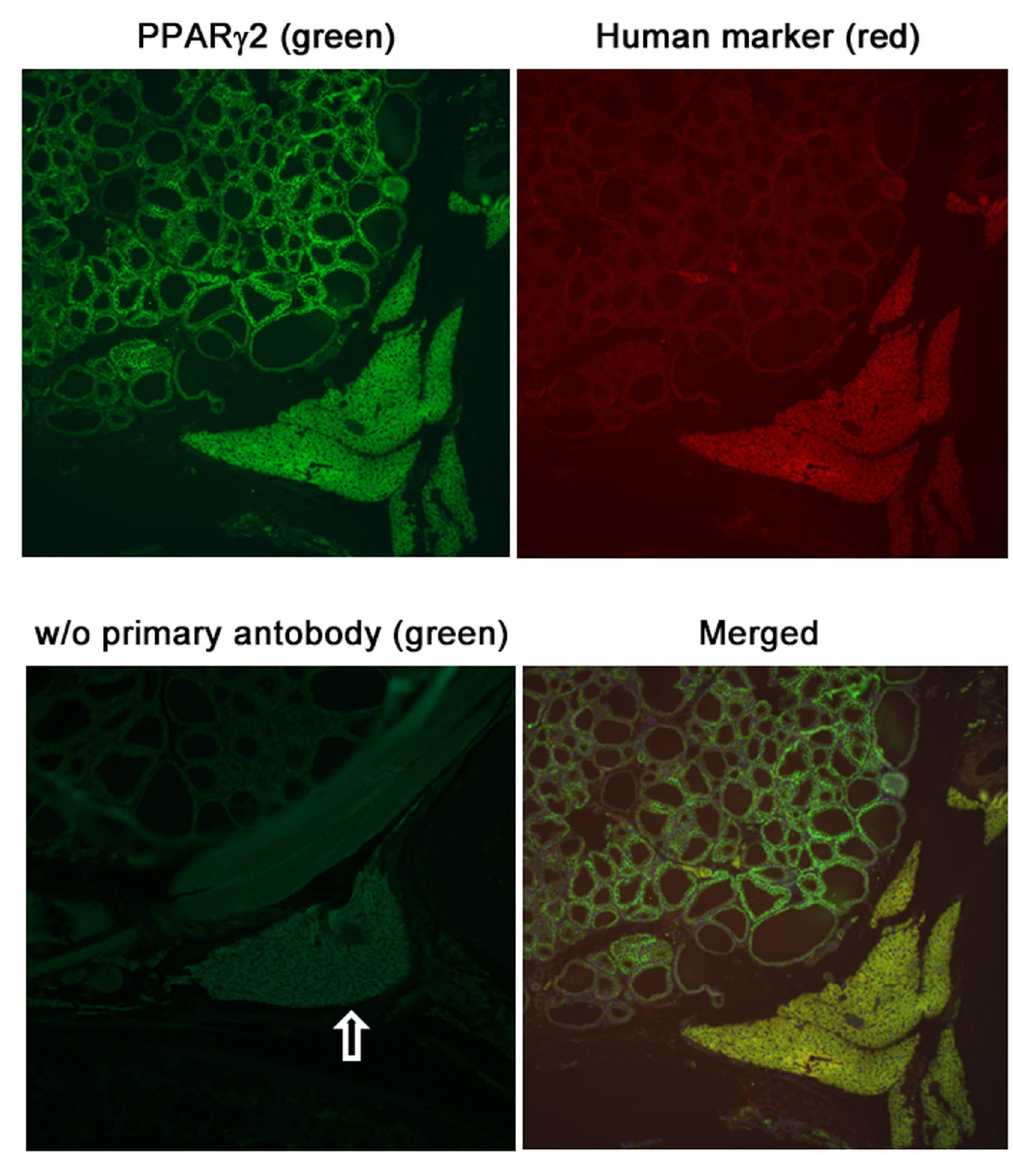
Figure 4. Post-transplant expression of PPAR γ 2 in transplanted parathyroid parenchymal tissues from secondary hyperparathyroidism patients. Parathyroid parenchymal tissues from secondary hyperparathyroidism patients transplanted into nude rats were recovered one to three-and-half months post-transplant and examined for PPAR γ 2 expression. A representative specimen recovered one-month post- transplant is shown. Bound anti-PPAR γ 2 antibody was fluorescently visualized with Alexa 488 (green) and bound anti-human cytoplasm antibody with Alexa 594 (red). These views were merged and are shown under Merged . As a negative staining control, the section was stained without the primary antibody and viewed with green fluorescence. The empty arrow indicates human